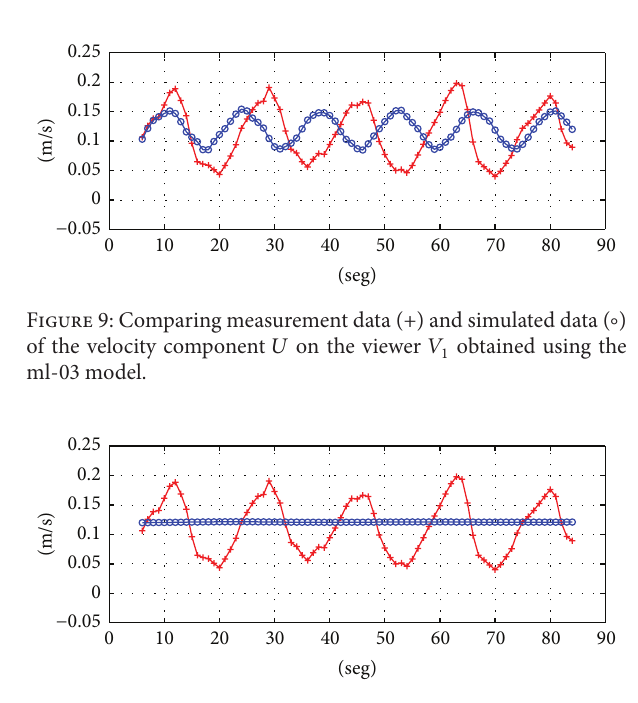
Figure 12: Comparing measurement data (+) and simulated data ( ∘ ) of the velocity component 𝑈 on the viewer 𝑉 1 obtained using the 𝑘 - 𝜖 + lm06.